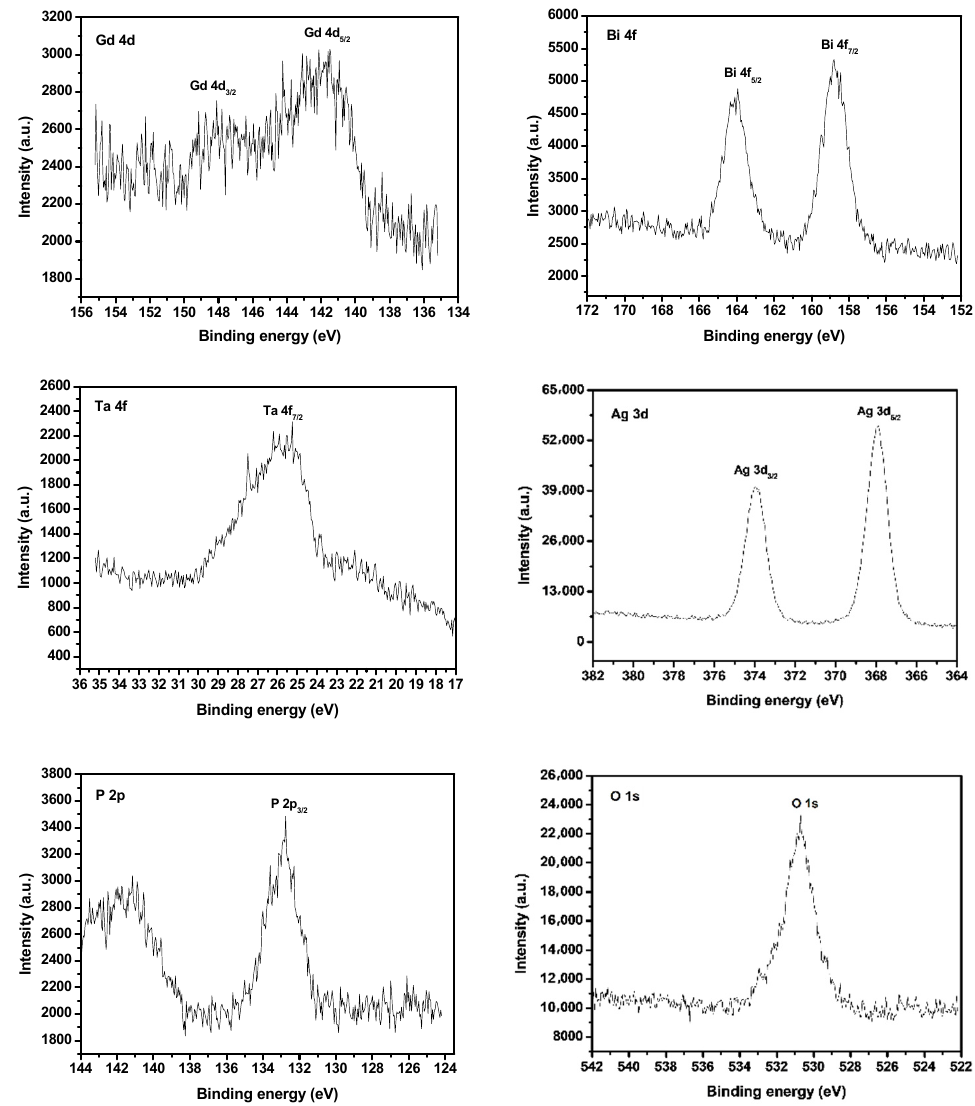
Figure 22. XPS spectra of O 2 − , Ag + , P 5+ , Gd 3+ , Bi 3+ and Ta 5+ from the Ag 3 PO 4 /Gd 2 BiTaO 7 heterojunction photocatalyst before the reaction of photocatalytic degradation of bisphenol A.